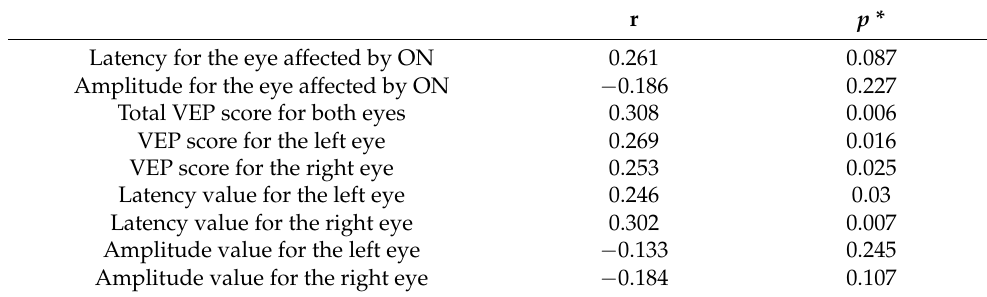
Table 5. Correlation of EDSS with latency and amplitude values and total VEP score obtained at disease